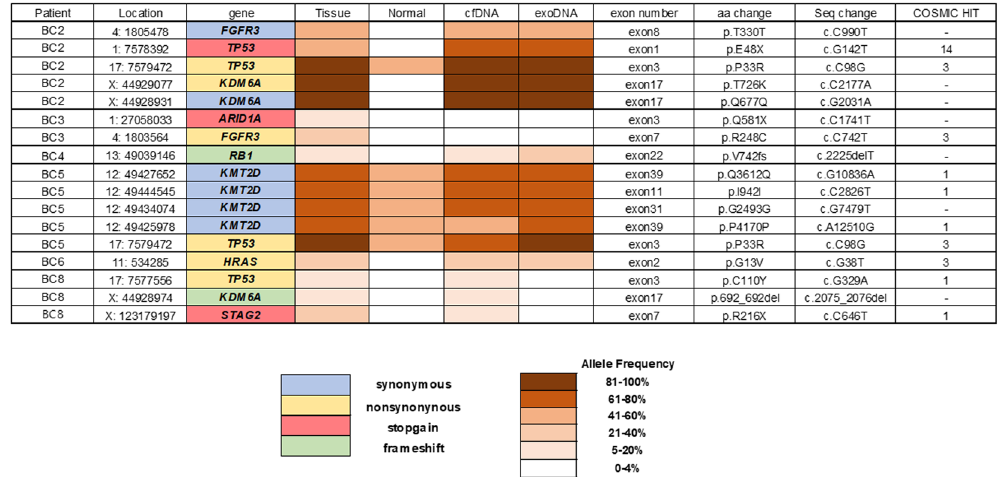
Figure 1. Somatic mutations identified in bladder cancer and genomic profiling in matched urinary cell free DNA and exosomal